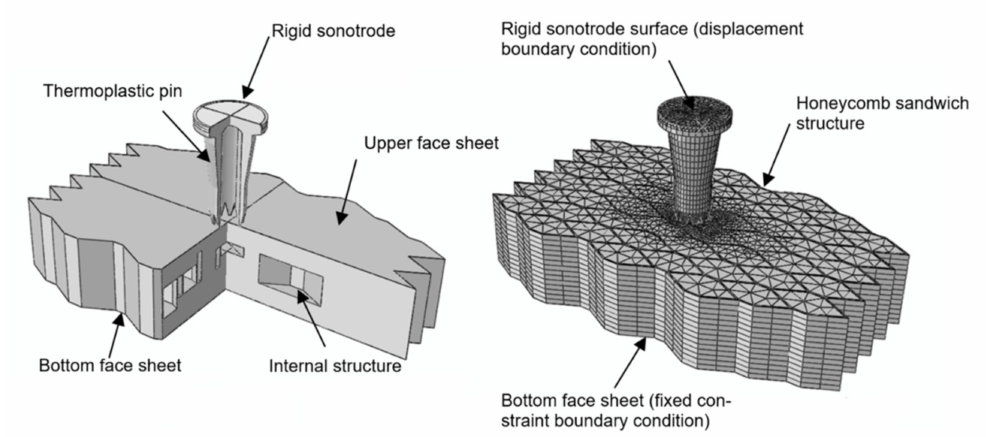
Figure 6. Overview of model assembly (thermoplastic pin, face sheet and internal structure) and resulting mesh with two node-based boundary